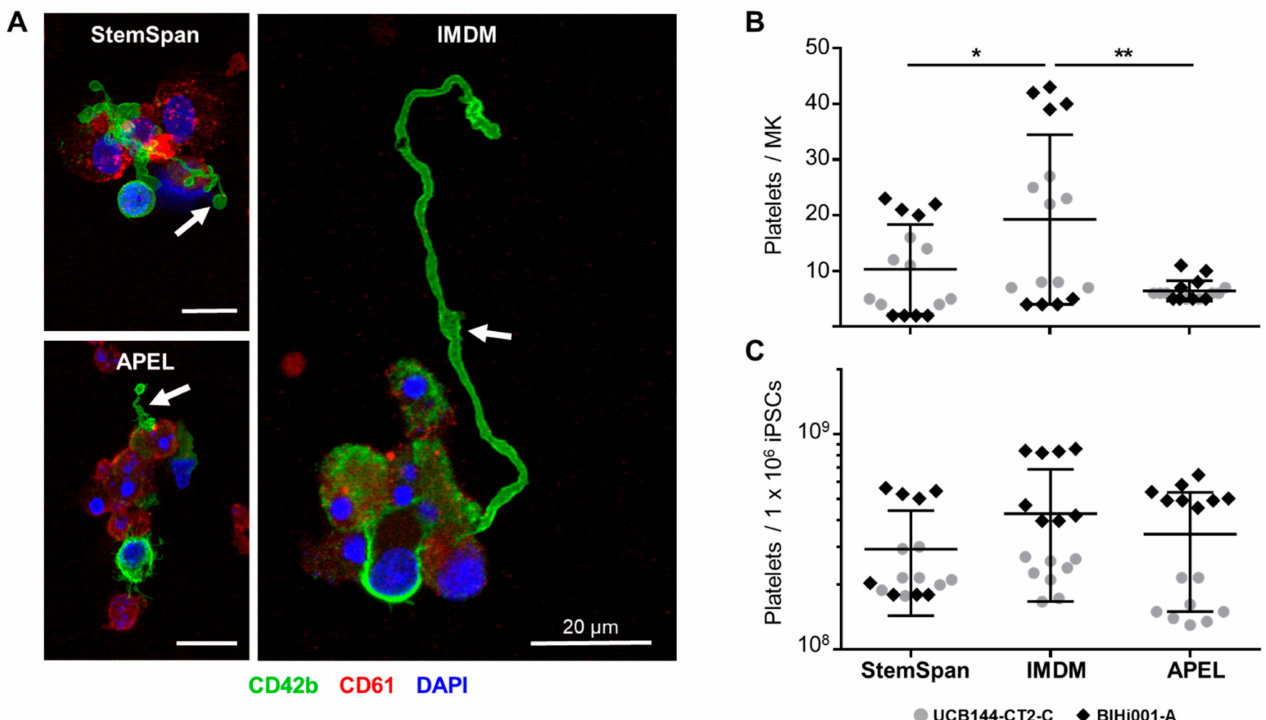
Figure 3. Human iPSC-derived megakaryocytes (MKs) produce pro-platelets and release platelets in all media conditions. ( A ) MKs with pro-platelet structures on day 9 + 12 (stage III) after dynamic culture in supplemented StemSpan, IMDM, and APEL media. Representative immunofluorescence images of MKs from one hiPSC clone (UCB144-CT2-C) stained with CD42b (green), CD61 (red), and DAPI (nuclei, blue) are shown. Pro-platelets are indicated by white arrows. ( B ) Platelet counts on day 9 + 12 (stage III) calculated per input MK were significantly increased after culture in supplemented IMDM medium, compared to StemSpan ( p = 0.046) and APEL medium ( p = 0.0273; both unpaired t-tests * p < 0.05 and ** p < 0.01). ( C ) Additional analysis showed comparable platelet counts per 1 × 10 6 input hiPSCs ( p > 0.05) in all media conditions. Results from two independent hiPSC clones (UCB144-CT2-C, grey circles, and BIHi001-A, black diamonds; n = 8, measured in